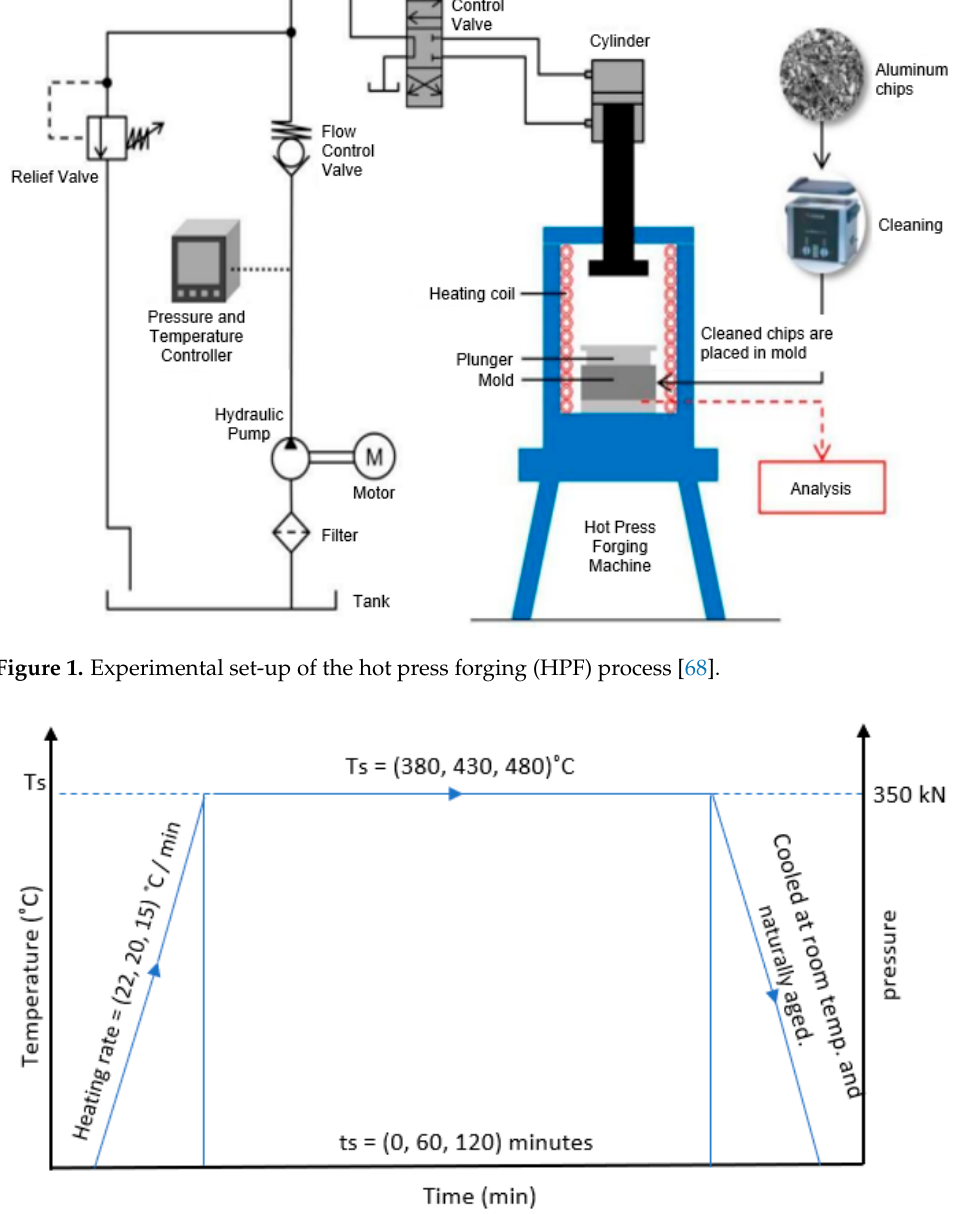
Figure 2. The HPF process diagram.